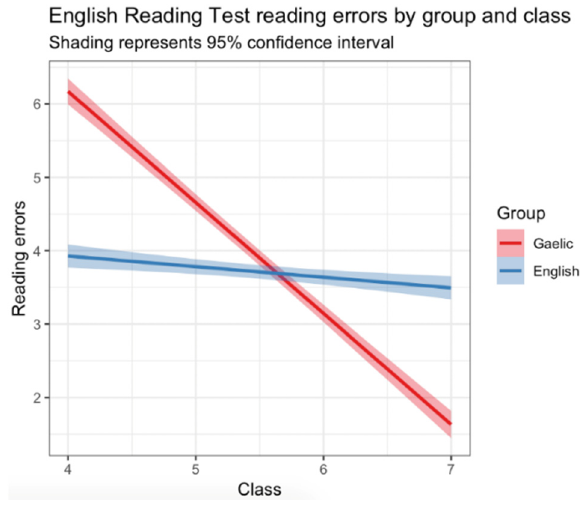
Figure 7. English Reading for All reading errors by group (Gaelic and English), by class.